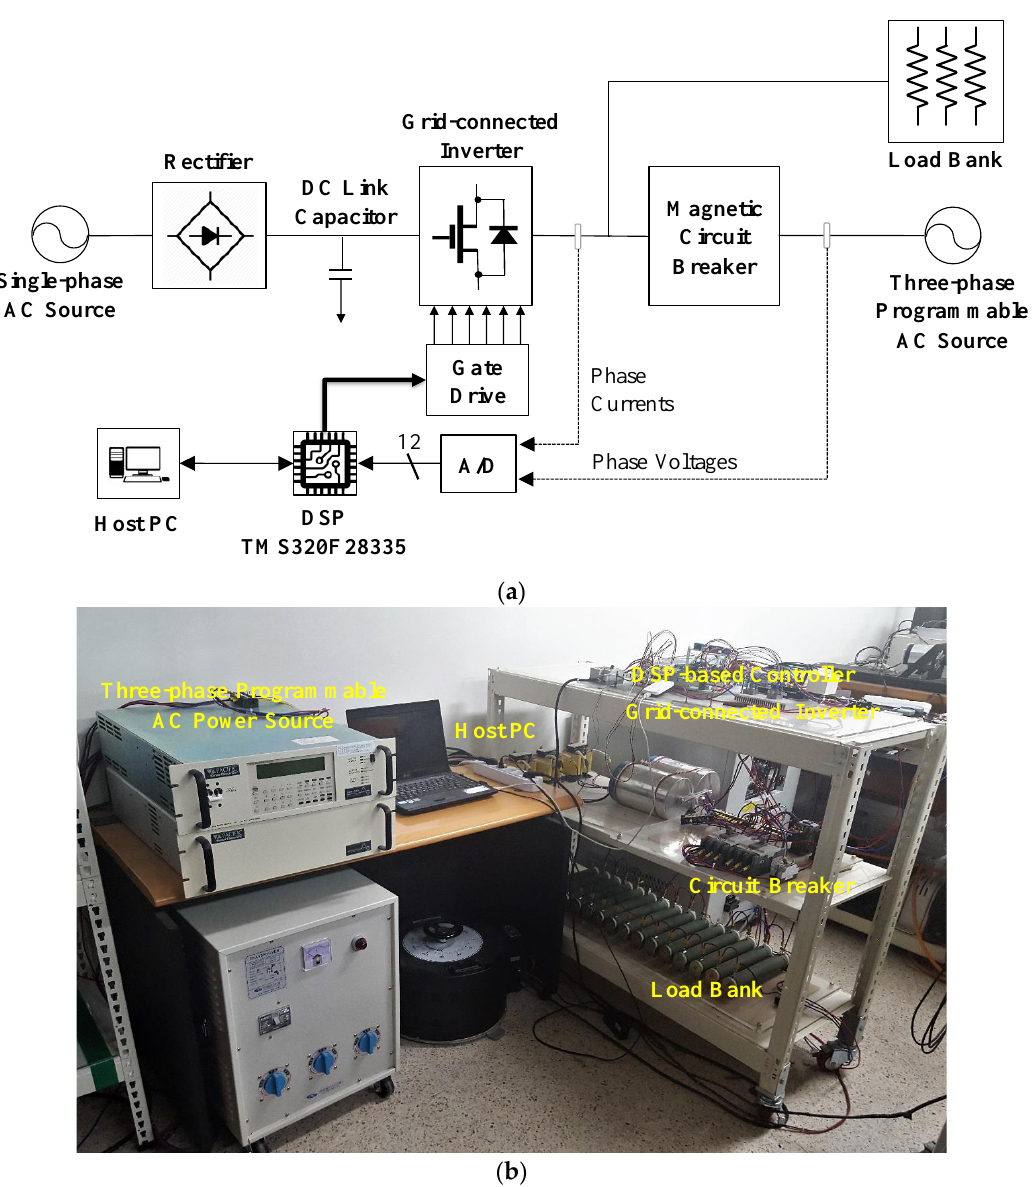
Figure 13. Configuration of the experimental system. ( a ) Block diagram of the overall system; ( b ) photograph of the experimental test setup.